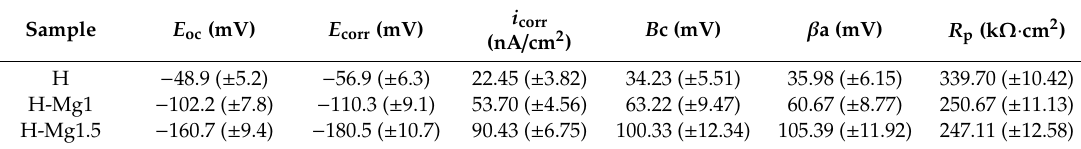
Figure 9. Open circuit potential curves ( a ) and Tafel plots ( b ) of the investigated coatings. Table 5. Electrochemical parameters of the investigated samples ( E oc -open circuit potential; E corr -corrosion potential; i corr -corrosion current density; R p -polarization